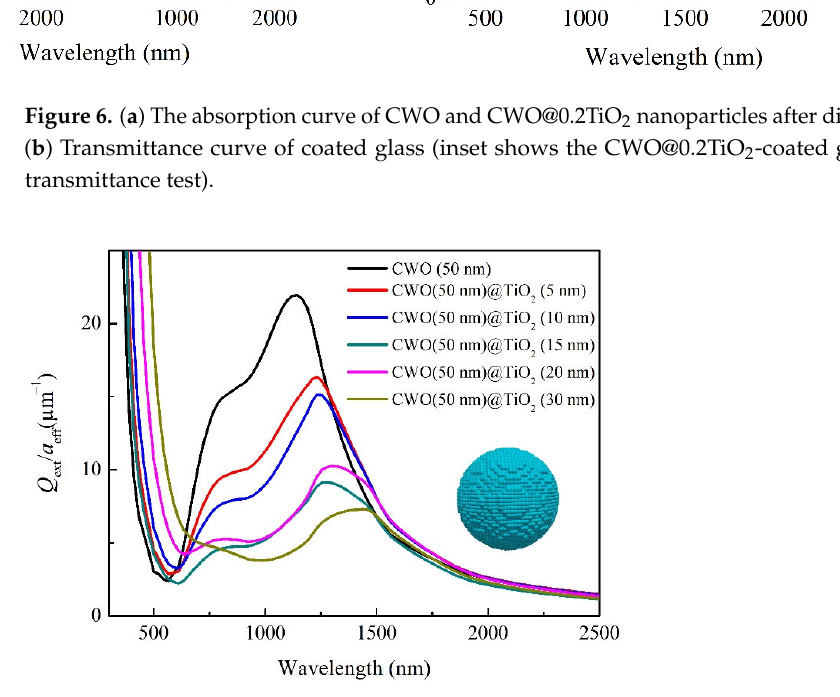
Figure 7. Extinction efficiencies of CWO spherical particles with different TiO 2 shell thicknesses.